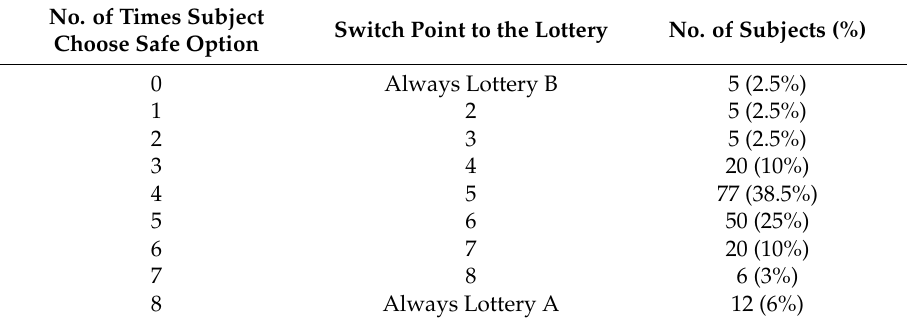
Table 4. Distribution of lottery choices in the